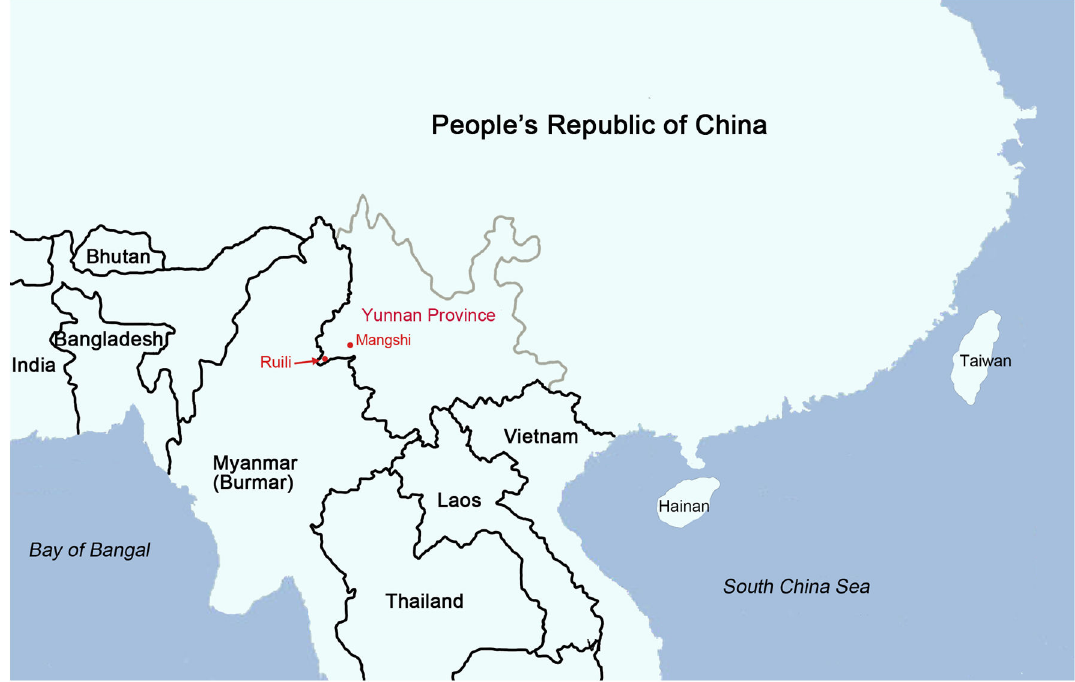
Figure 1. Location of villages in Mangshi and Ruili, Yunnan Province, China, where mosquito collection occurred. doi: